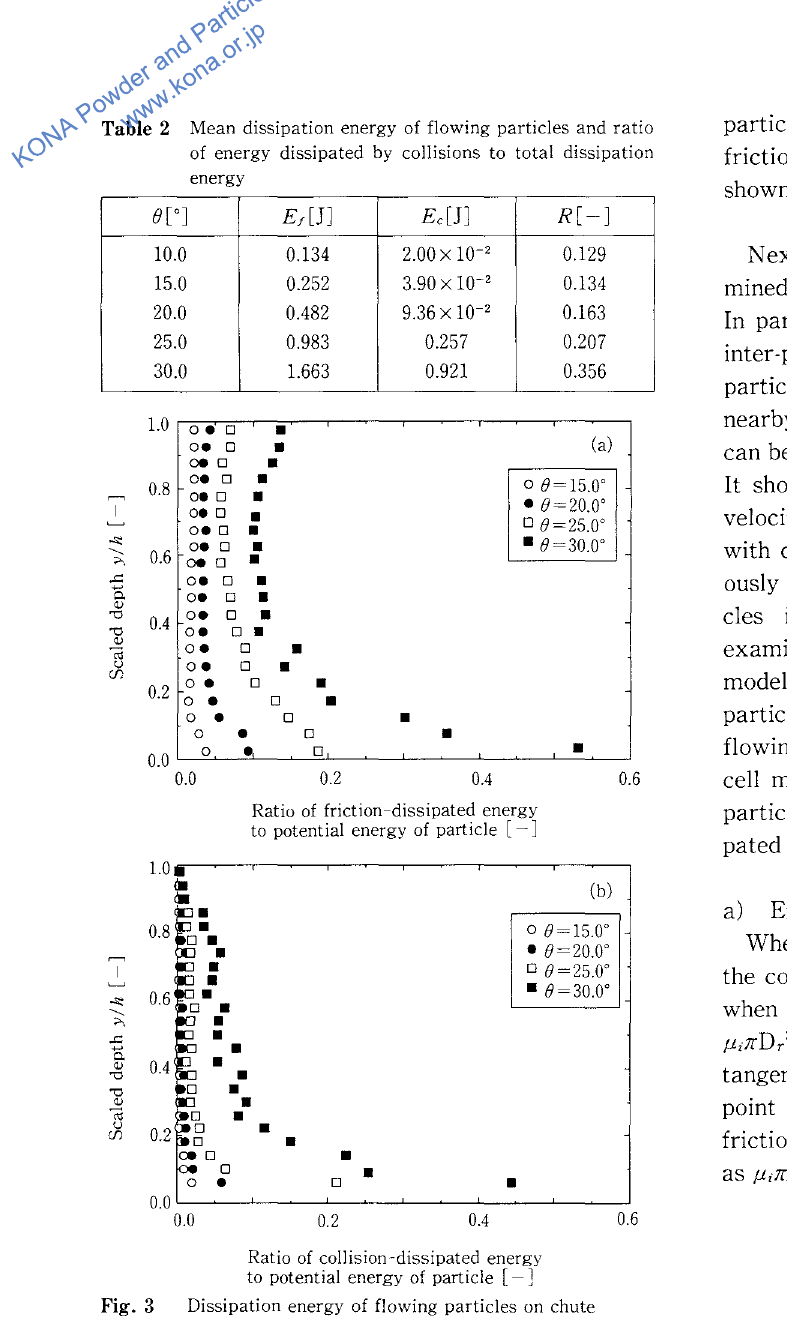
Dissipation energy of flowing particles on chute